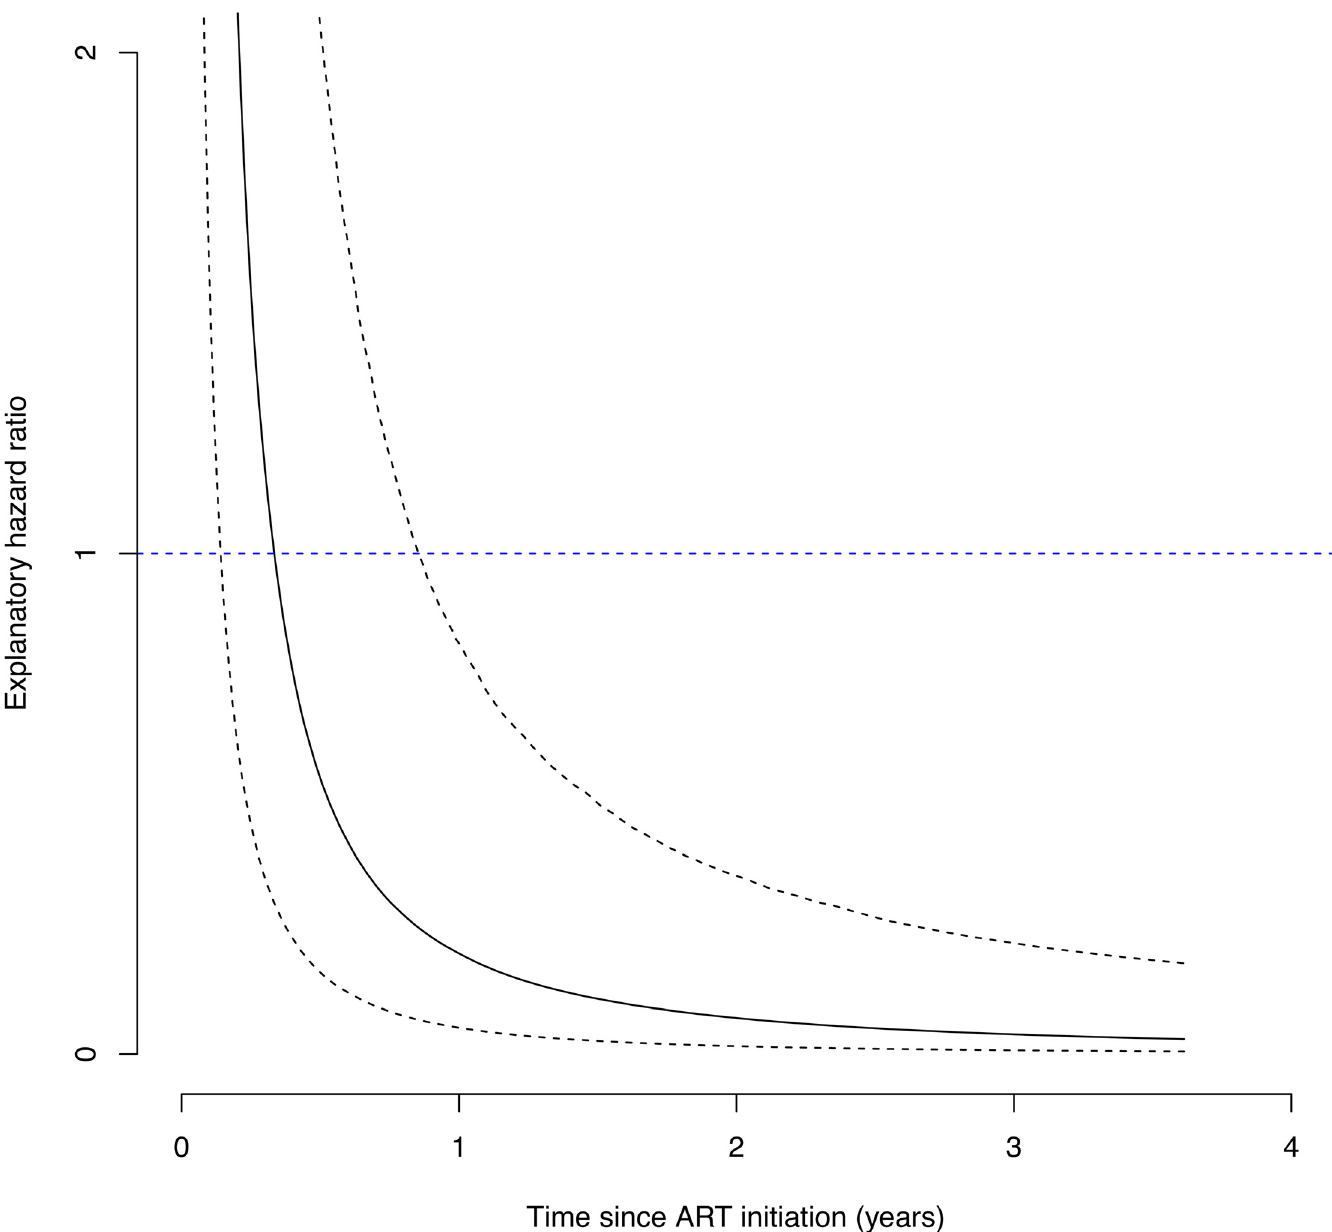
Fig 3. Explanatory Hazard Ratio in Semi-Competing Risks Analysis. The ratio of hazards for death after and before AIDS. If the risk of death is not influenced by the risk of AIDS (i.e., time to AIDS and death are independent) the ratio is equal to one (the blue horizontal line). Dotted lines indicate ranges of 95%